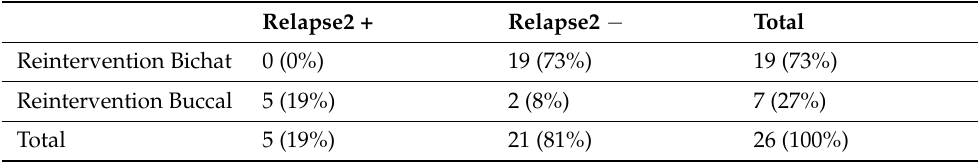
Table 7. Reintervention using Bichat fat pad flap and Buccal flap. Relapse2 + Relapse2 − Total Table 8. Crosstabulation for palatal flaps and buccal advancement flaps regarding relapses. Reintervention Bichat 0 (0%) Relapse + Relapse − Total Buccal flap 25 (27%) Palatal